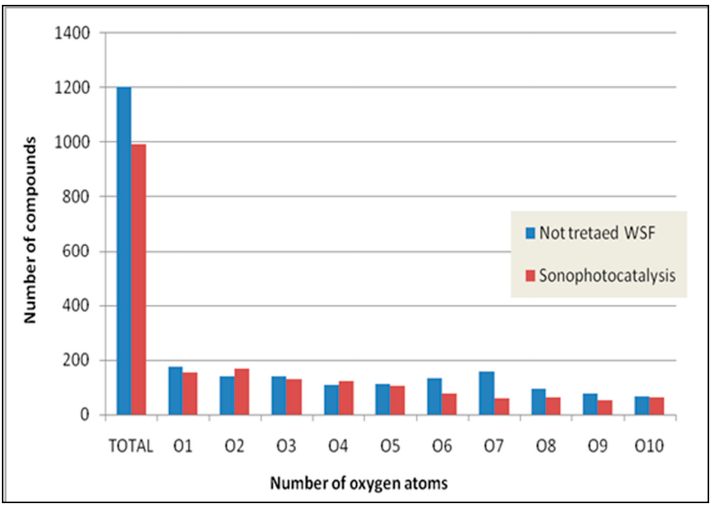
Figure 12. FT-ICR MS analysis of natural and 1-h sonophotocatalysed WSF sample of crude oil as a function of the number of oxygen atoms.